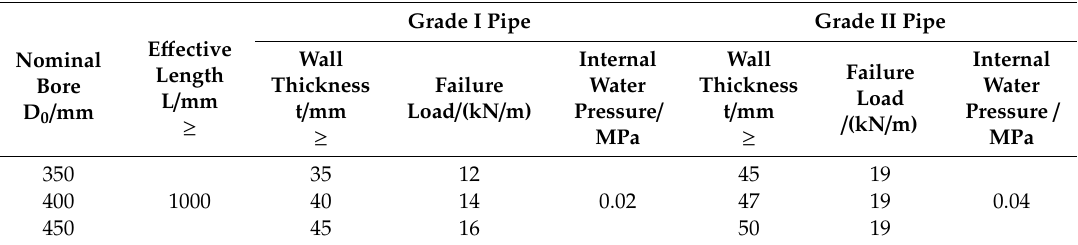
Table 4. Concrete pipe specifications and indicators of external pressure load